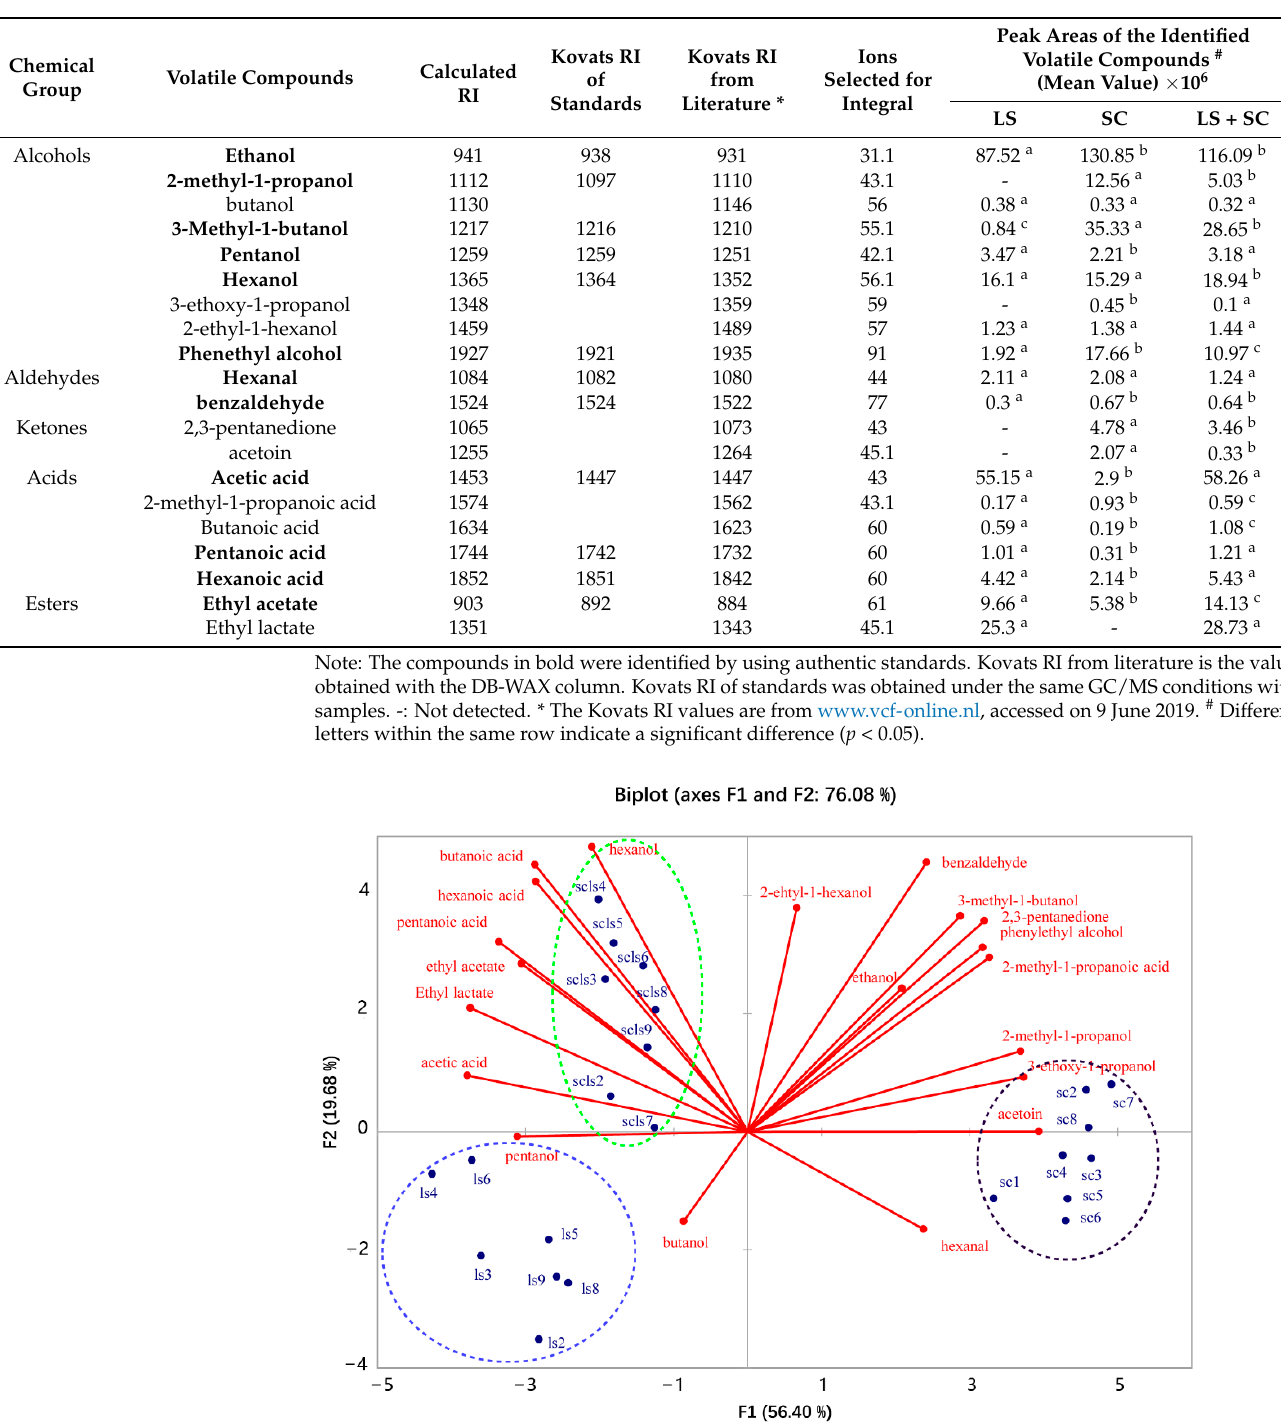
Table 1. The identified and tentatively identified volatile compounds in the fermented dough.